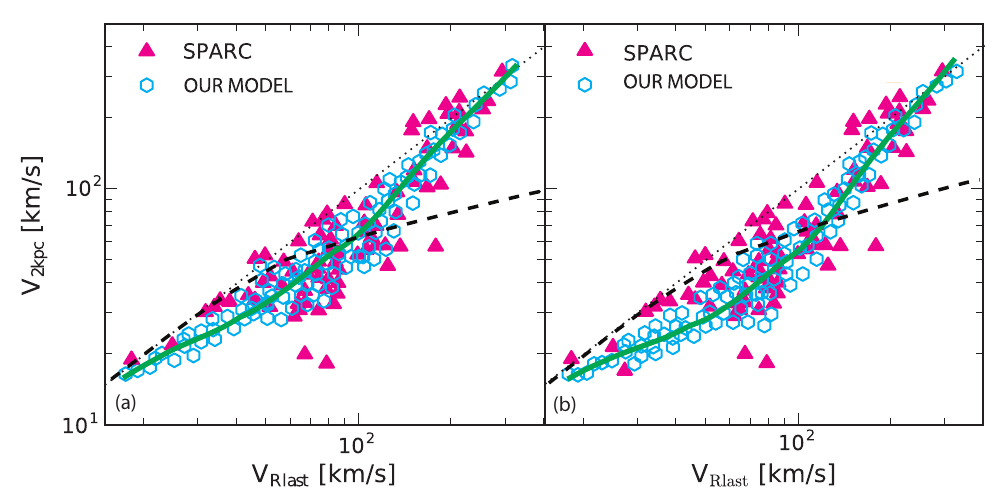
Figure 1. The prediction from our model and a selection of SPARC data, using ( a ) (left panel) the spherical circular velocity approximation and ( b ) (right panel) the disk plane cylindrical gravitational potential approximation. The full triangles represent the SPARC sample, the open blue hexagons represent our simulated galaxies, the green line represents the mean trend line, and the dashed line represents the expectation when an NFW profile describes all